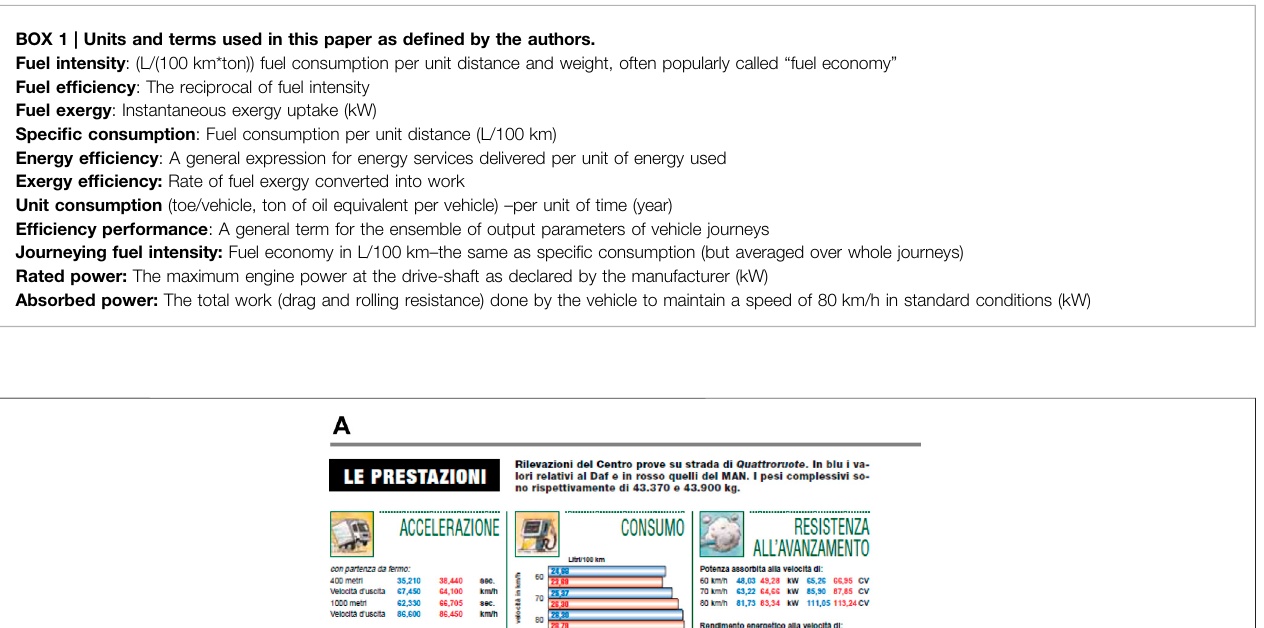
Frontiers in Energy Research |